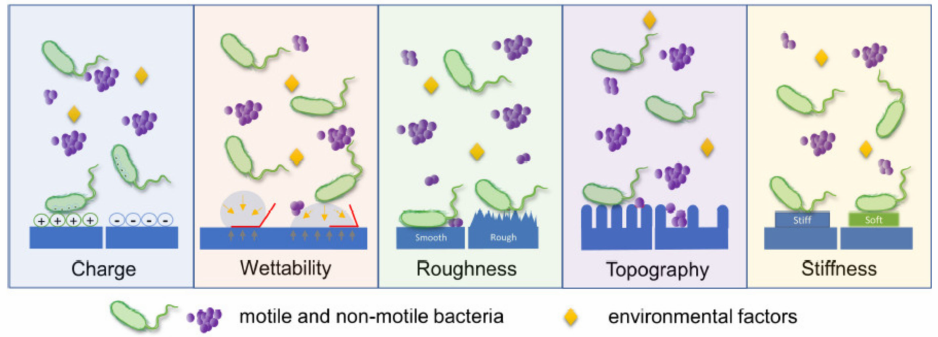
Figure 1. Materials’ surface characteristics that influence the adhesion of microbes. The figure is taken from the publication from Zeng et al. [33] in accordance with copyright permission guidelines of the journal, CC BY